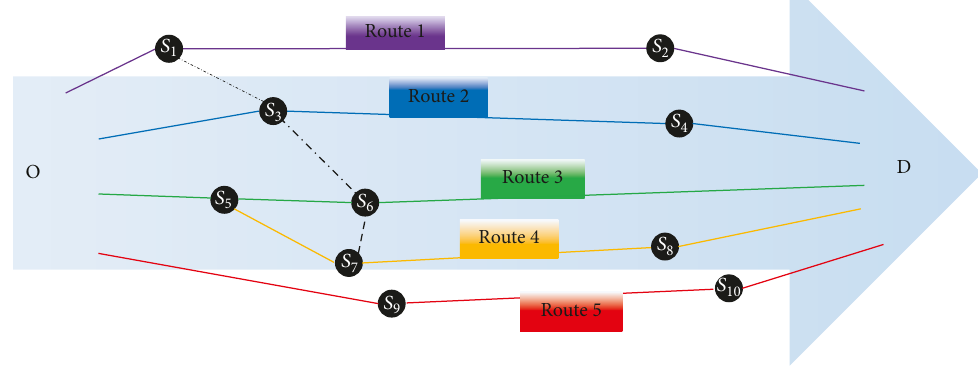
Figure 4: Sketch of impact on stations.